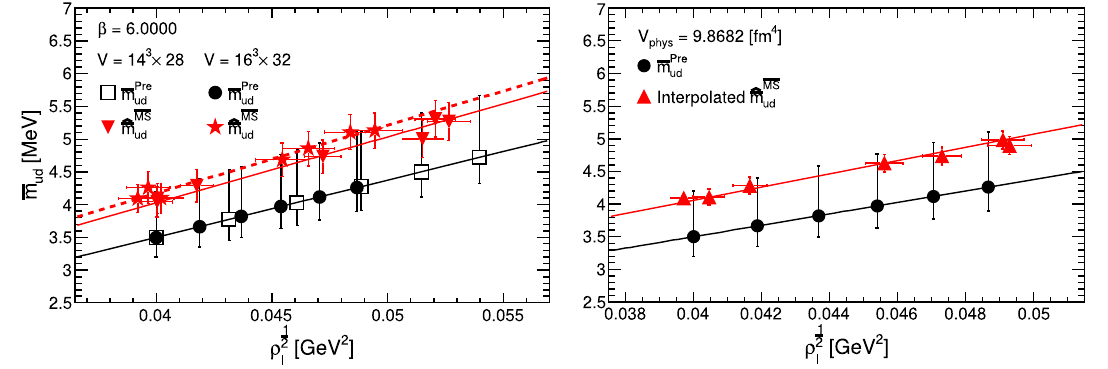
Fig. 16 Comparisons of the renormalized average quark mass ˆ¯ m MS in the MS-scheme at 2 [GeV] of the configurations of V = 14 3 × 28 and V = 16 3 × 32 of β = 6 . 0000 (left) and the interpolated results at the continuum limit (right) with the predictions ¯ m Pre